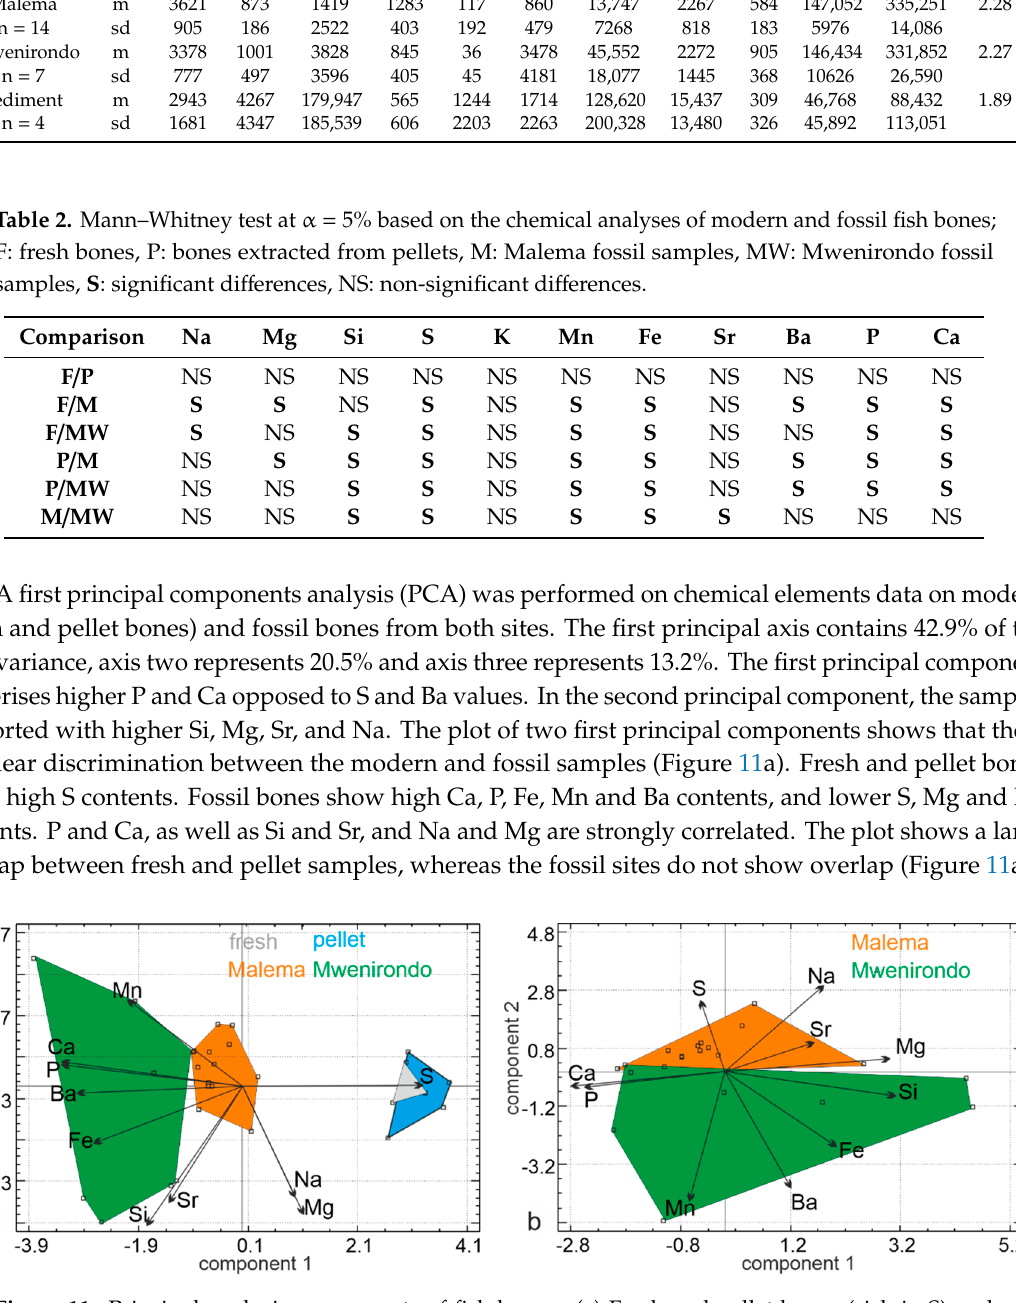
Figure 10. Principal analysis components of fish bones. ( a ) Fresh and pellet bones (rich in S) and fossil bones (rich in P, Ca, Fe and Ba). ( b ) Chemical compositions of fossil bones of Malema and Mwenirondo differ.